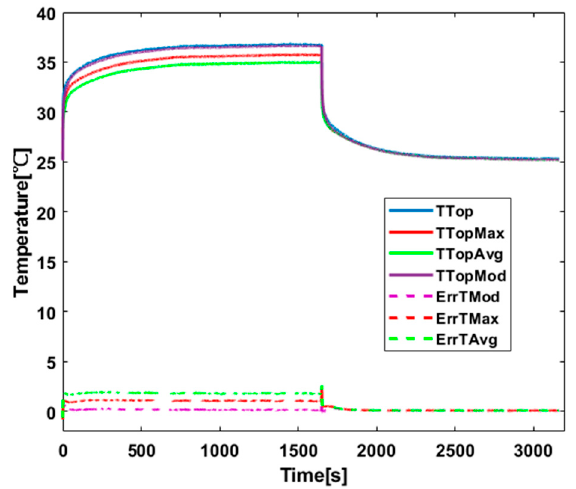
Figure 11. Measured vs. model temperatures 3rd order top transistor active 50A 5 m/s air flowrate.